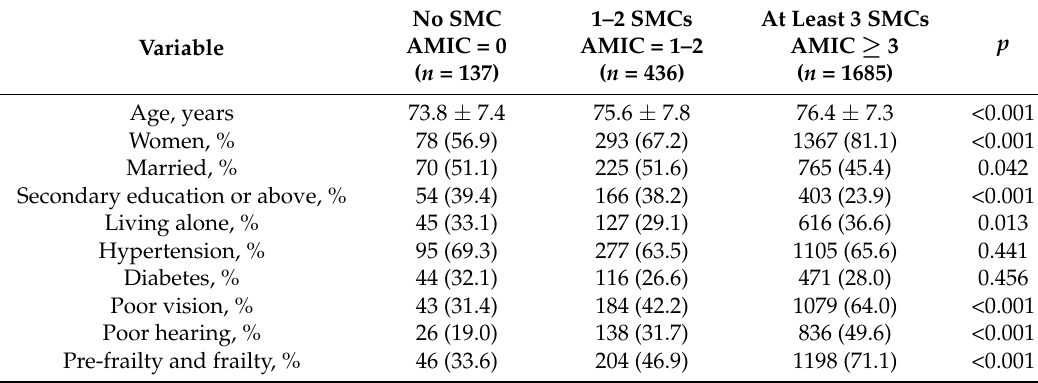
Table 2. Baseline characteristics of the study population by cognitive status ( n = 2258